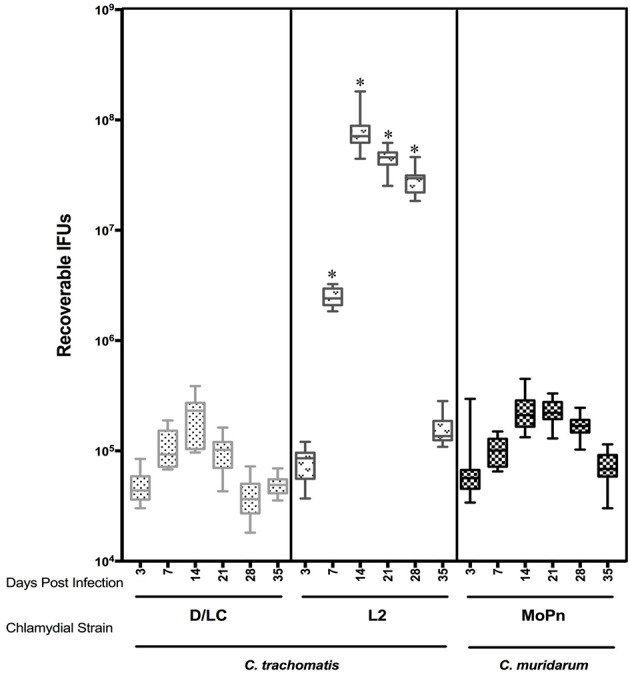
Comparison of recoverable infectious forming units (IFUs) obtained from C3H/HeJ mice between C. trachomatis (serovars D-LC, L2) and C. muridarum (MoPn) infection. Mice were intravaginally infected with 1X 106 EBs of corresponding Chlamydial strain. Recoverable IFUs were obtained by swabbing vaginal tracts and enumerating on HeLa cell monolayers. IFU data are expressed (mean ± SE) for each Chlamydial strain from day 3 to35 post infection.*p < 0.001 (L2 vs. D-LC, L2 vs. MoPn), One way ANOVA.